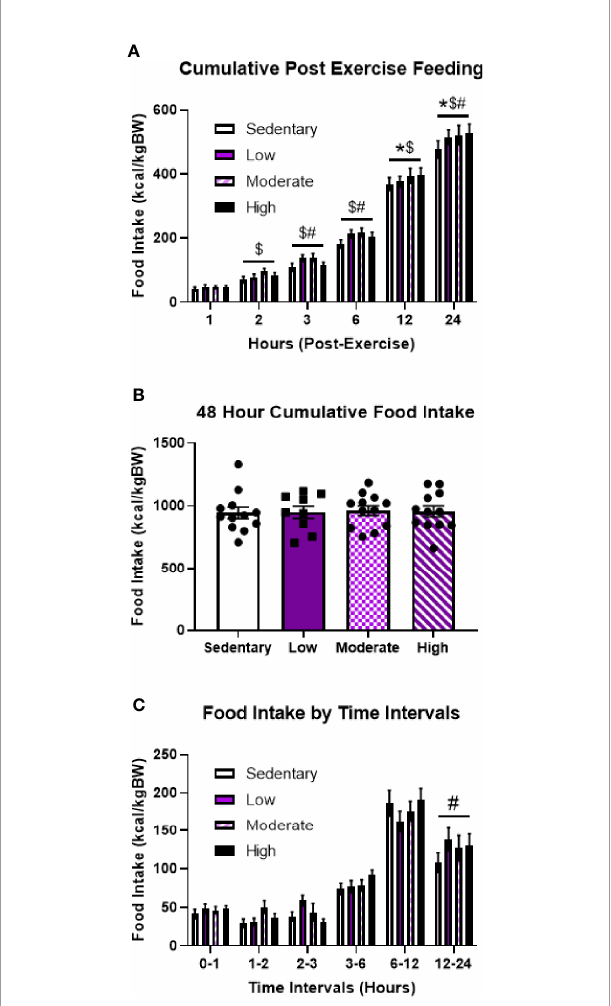
FIGURE 4 | Regardless of intensity, acute treadmill exercise increases food intake in fed male mice. (A) Timeline of cumulative food intake, (B) 48-hour cumulative food intake, and (C) food intake by time intervals in fed male mice in response to different acute treadmill exercise intensities (n = 11). Data represented as mean ± SEM. *indicates p < 0.05 high intensity vs. sedentary; $ indicates p < 0.05 moderate intensity vs. sedentary; # indicates p < 0.05 low intensity vs.